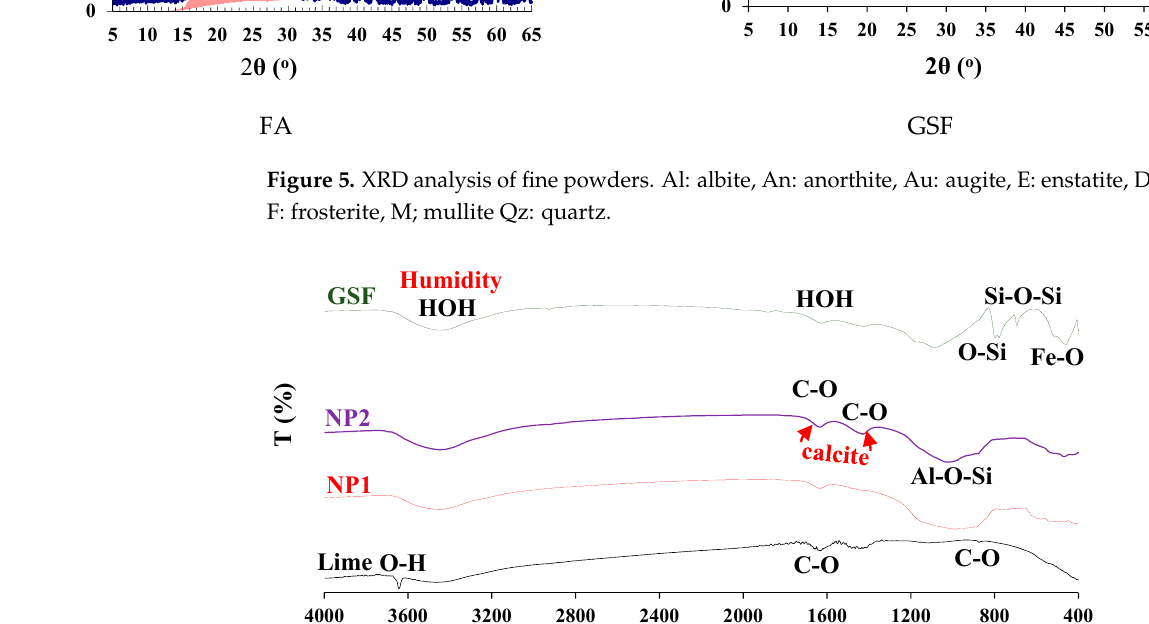
Figure 6. FT − IR of lime, NP1, NP2, and GSF powders.